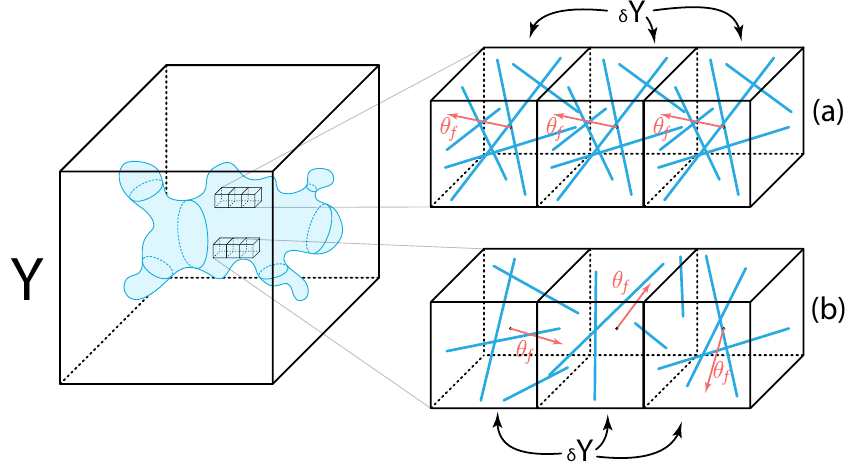
Figure 2. Schematics of the initial condition of the micro-fibres (blue lines) within a micro-domain δ Y ( x ) of orientation θ f ( x , t ) located in the ( a ) white matter and in the ( b ) grey